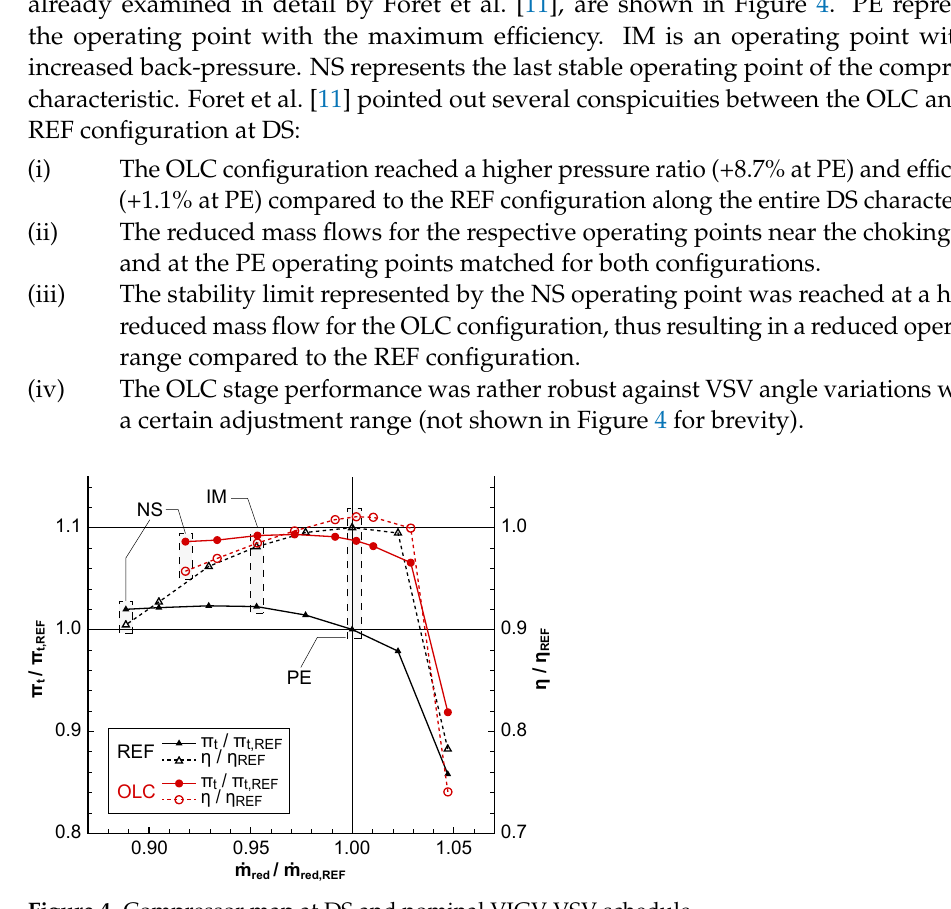
Figure 4. Compressor map at DS and nominal